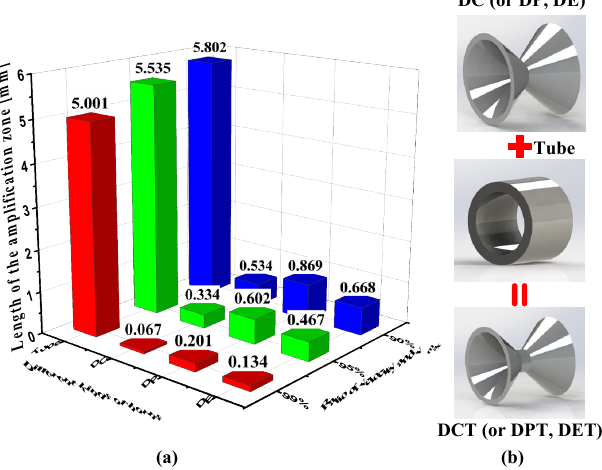
Figure 5. ( a ) The length of amplification zone of four different kinds of acoustic horns with acoustic particle velocity greater than 99%, 95%, and 90% of v max , respectively. ( b ) Replacing the throat of DC horns with the tube